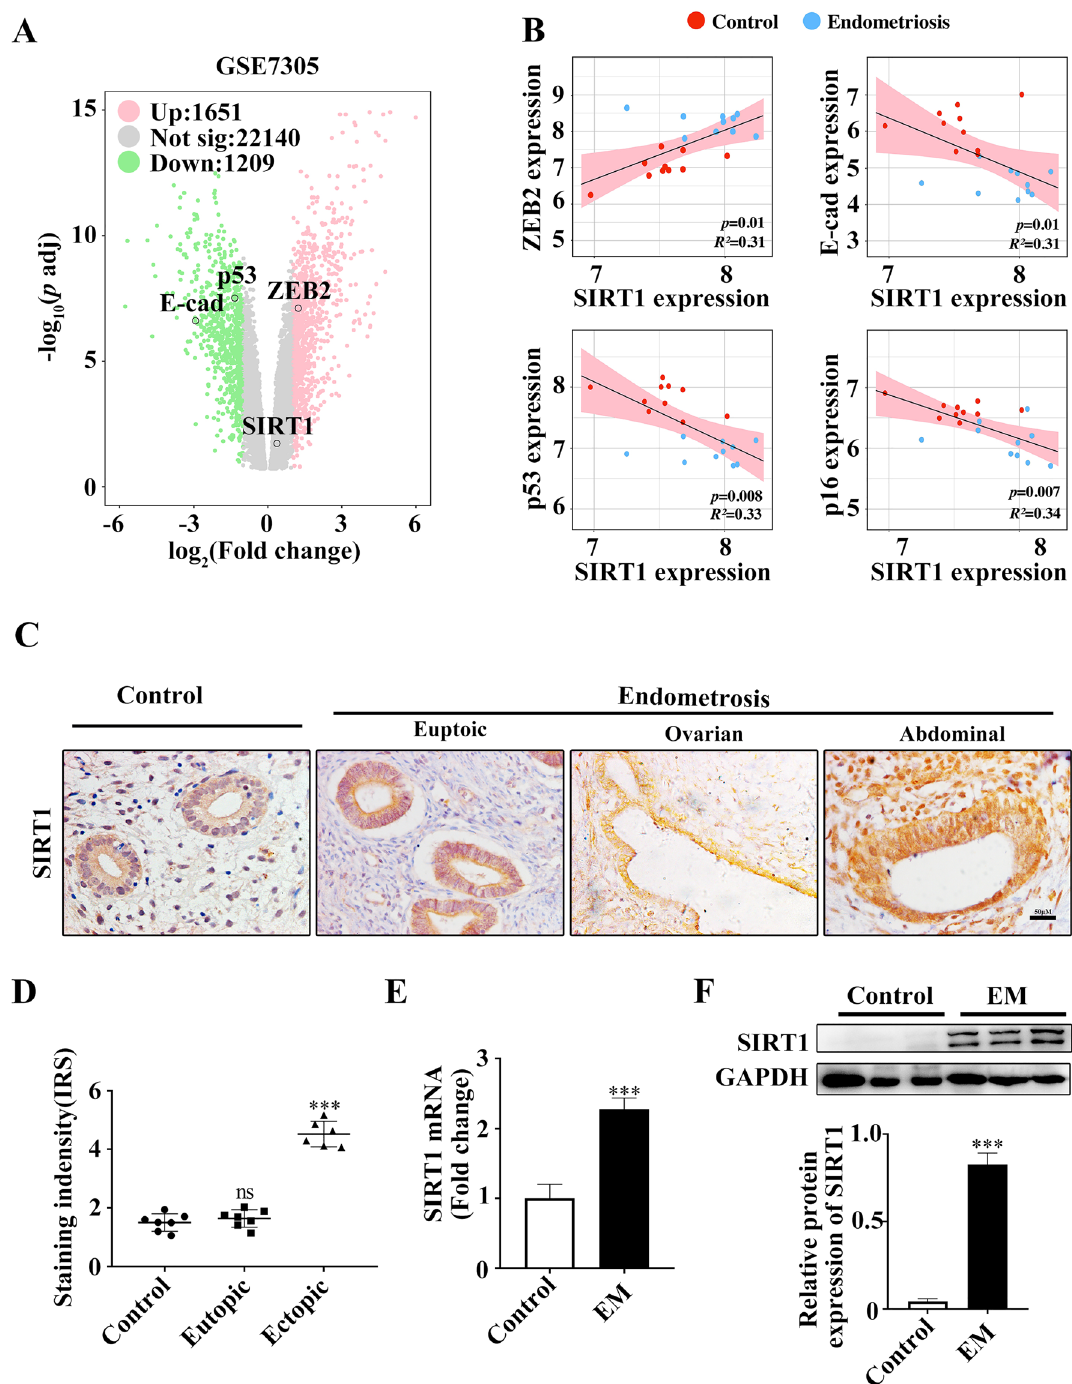
Figure 5. The expression of SIRT1 was unregulated in endometriosis. A volcano plot shows the high expression of SIRT1 and ZEB2 and the low expression of E-cad and p53 in endometriosis ( A ). Correlation analysis of SIRT1 with ZEB2, E-cad, p53 and p16 in endometriosis ( B ). Representative images of SIRT1 expression were detected by IHC in control and endometriotic endometria ( C ). Dot plot of the IRS scores. The differences were analysed by Student’s t-test. *** p < 0.001 ( D ). qPCR ( E ) and western blots ( F ) were used to detect the SIRT1 expression levels in the control and endometriotic endometrium. E-cad E-cadherin, EM endometriosis. Scale bars = 50 µm in ( C